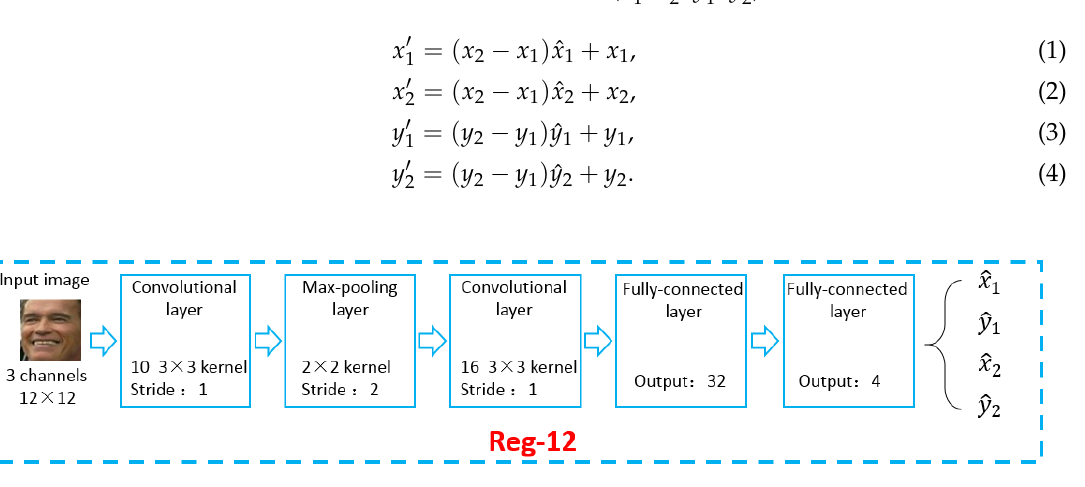
Figure 6. The CNN structure of